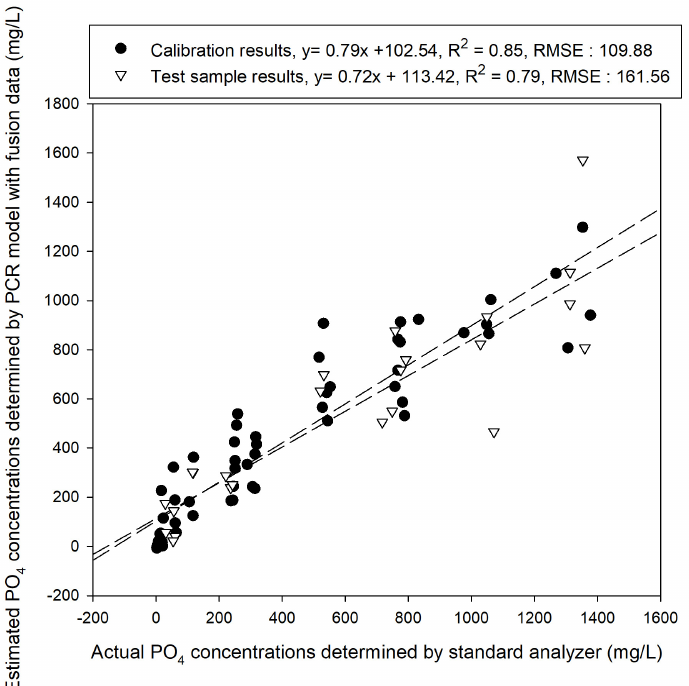
Figure 11. Calibration and test sample prediction results with PCR analysis performed using the combined data.